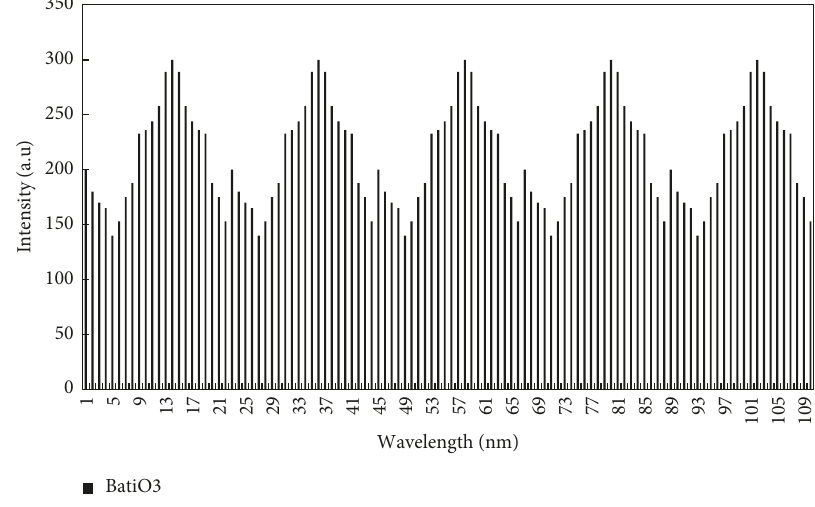
Figure 8: Changes in the luminous intensity of